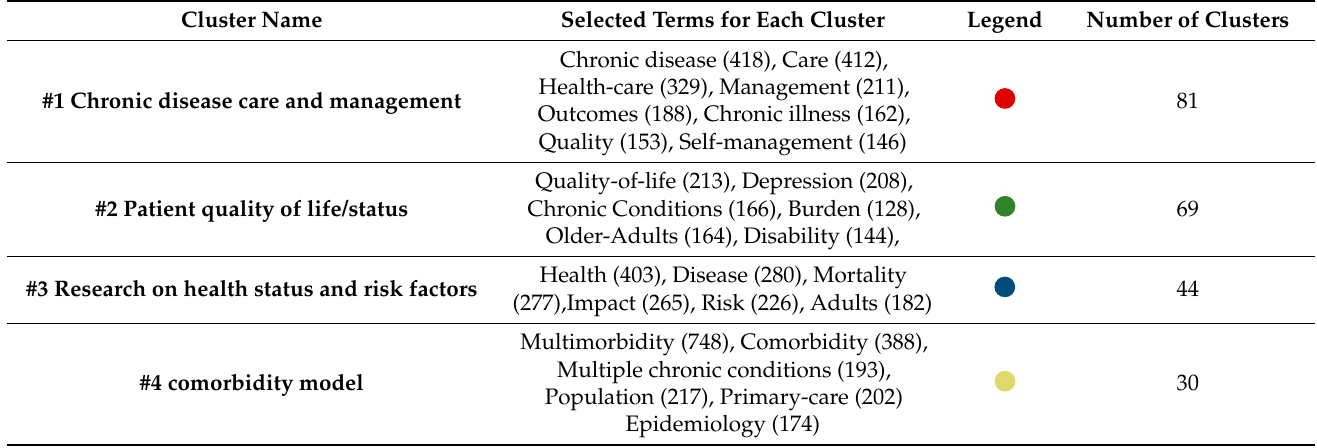
Table 4. Cluster keywords analysis of English articles.